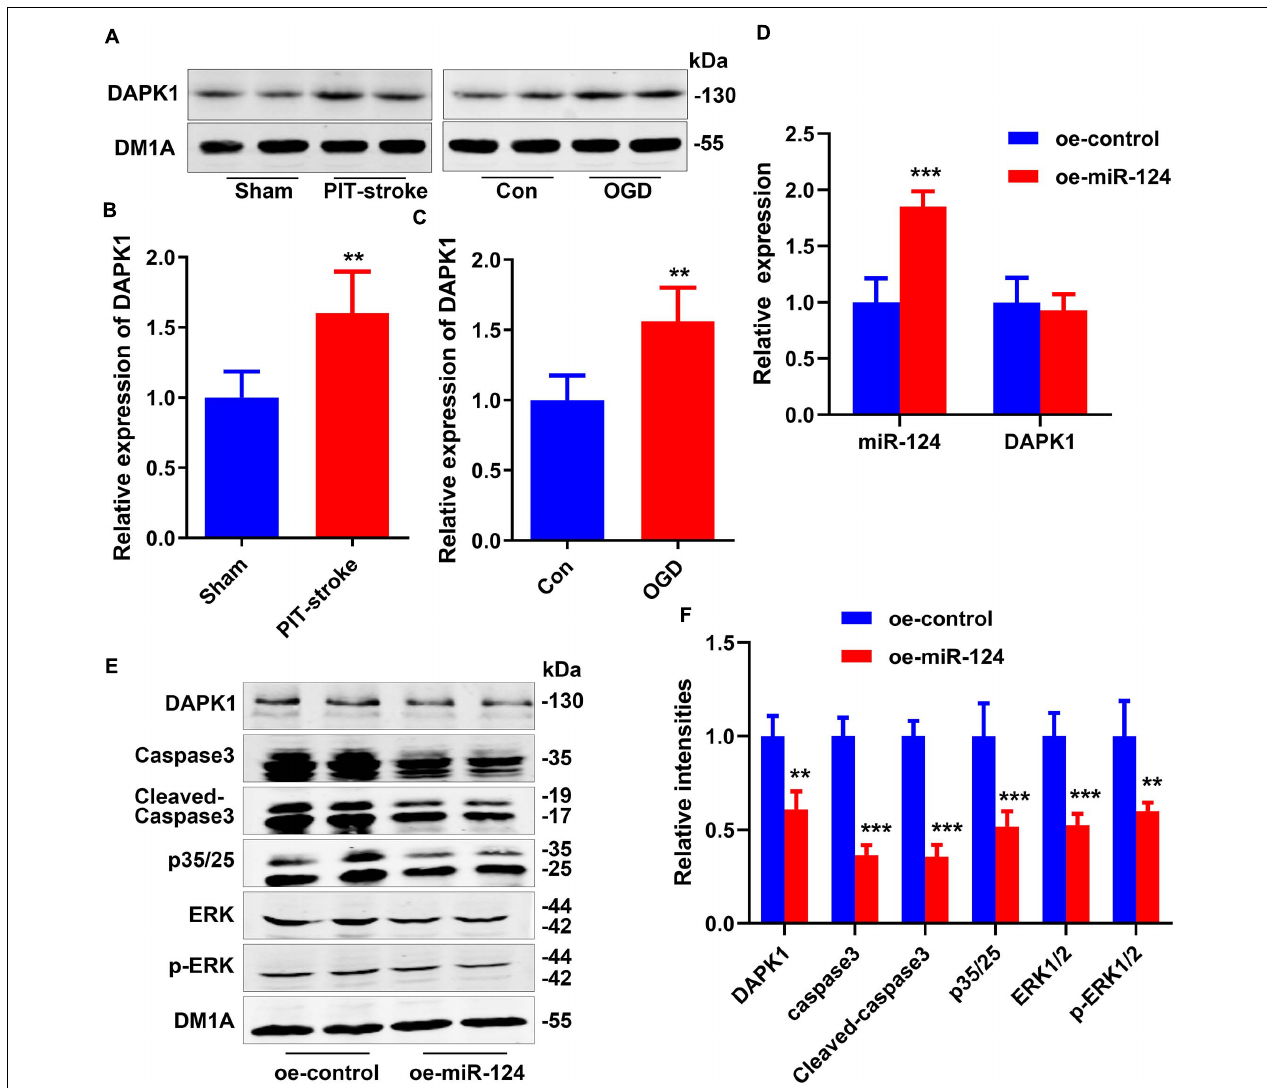
FIGURE 2 | DAPK1 was identified as a target gene of miR-124. DAPK1 levels were measured by western blotting (A) and quantitatively analyzed (B,C) . Data are presented as mean ± SD ( n = 4/group). ** p < 0.01, *** p < 0.001 vs. Con or Sham group. N2a cells were transfected with miR-124 (oe-miR-124) or control-treated (oe-control) cells. Levels of miR-124 and DAPK1 mRNA were measured by qRT-PCR (D) . Levels of DAPK1, caspase-3, cleaved caspase-3, p35/25, ERK1/2, and p-ERK1/2 were measured by western blotting (E) and quantitatively analyzed (F) . Data are presented as mean ± SD ( n = 4/group). ** p < 0.01, *** p < 0.001 vs. oe-control